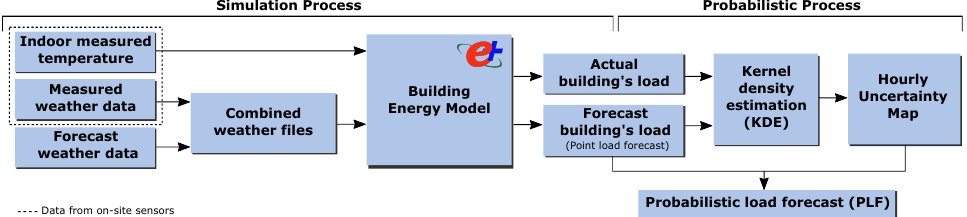
Figure 1. Components and steps of the probabilistic load forecasting procedure based on white-box models (building energy model (BEM))